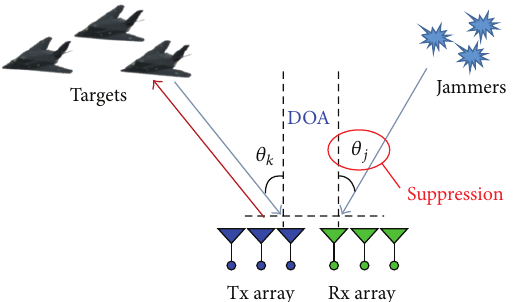
Figure 1: Simulation geometry for collocated MIMO radar signal model.